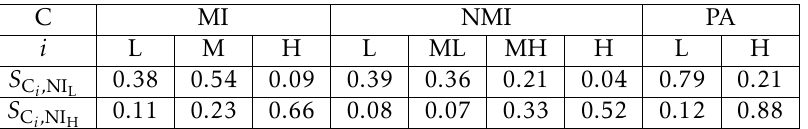
Table 7. Median and mean ( ± standard deviation) values of ∆